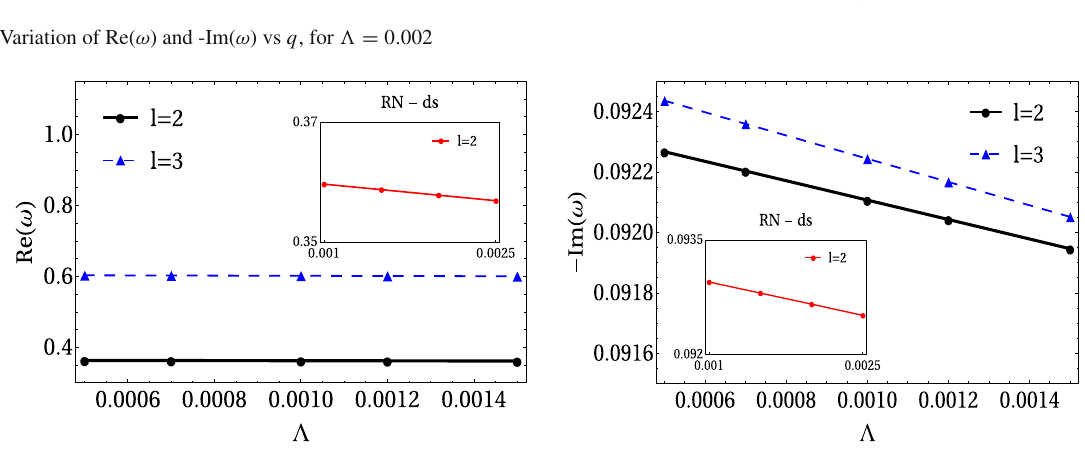
Fig. 10 Variation of Re( ω ) and -Im( ω ) vs (cid:2) for q = 0 .